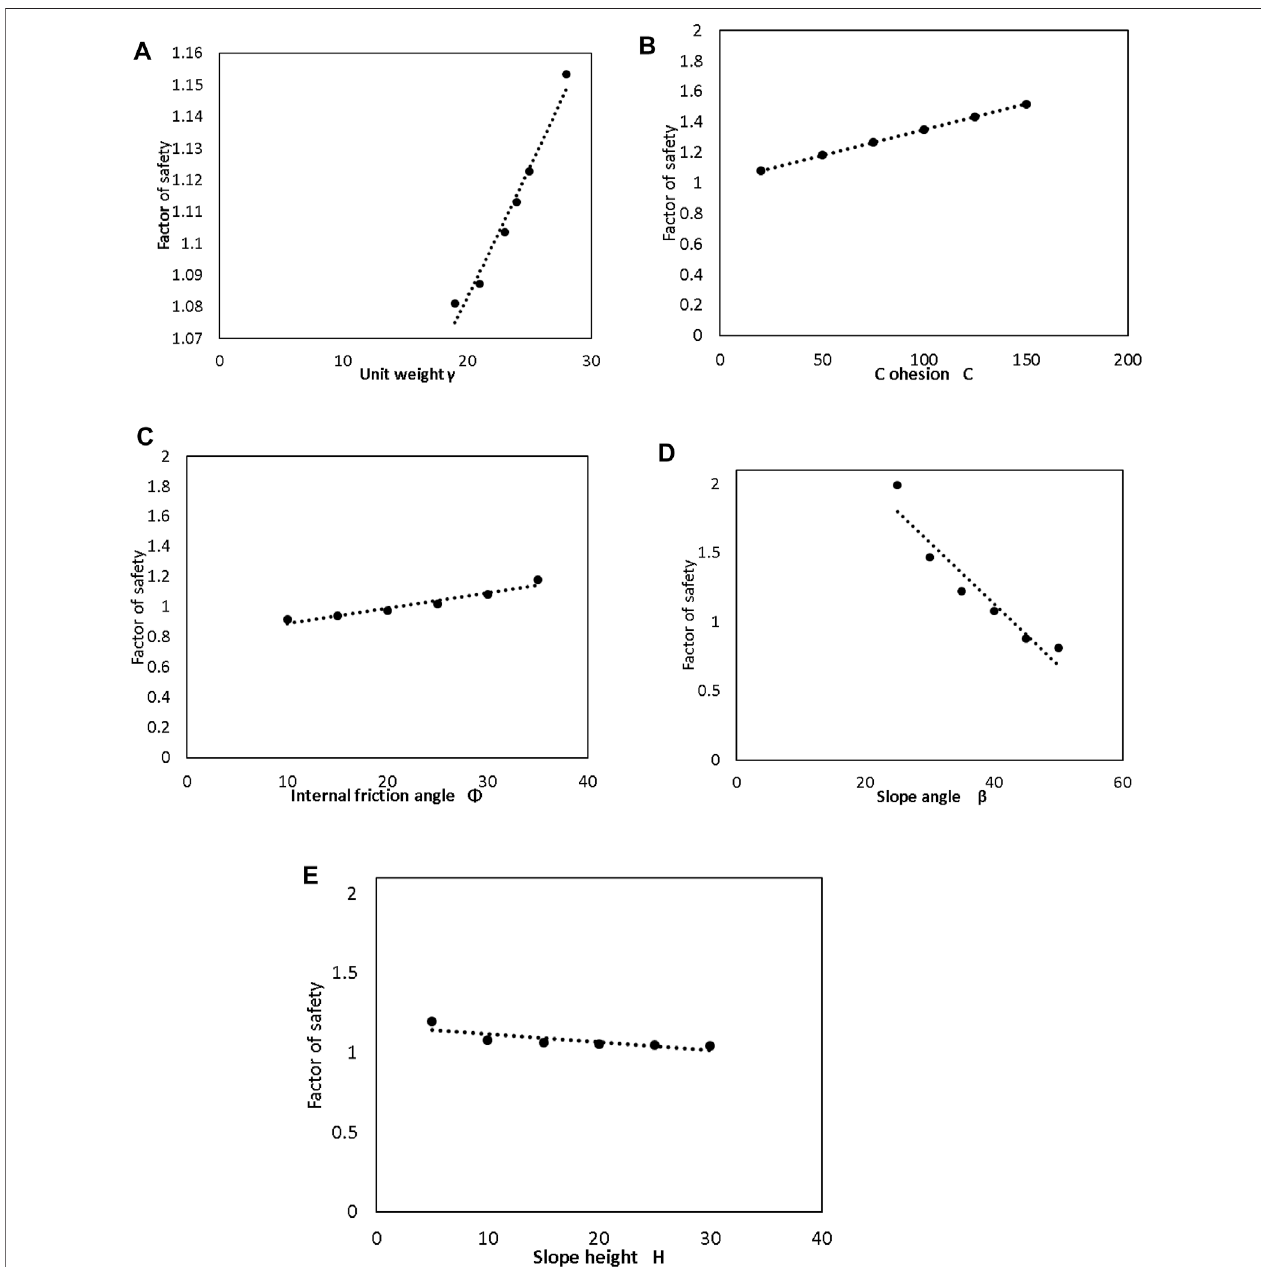
FIGURE 10 | Parametric study for input variables. (A) . Unit weight vs. factor of safety. (B) . Cohesion vs. Factor of Safety. (C) . Internal Friction Angle vs. Factor of Safety. (D) . Slope Angle vs. Factor of Safety. (E) . Slope height vs. Factor of safety.